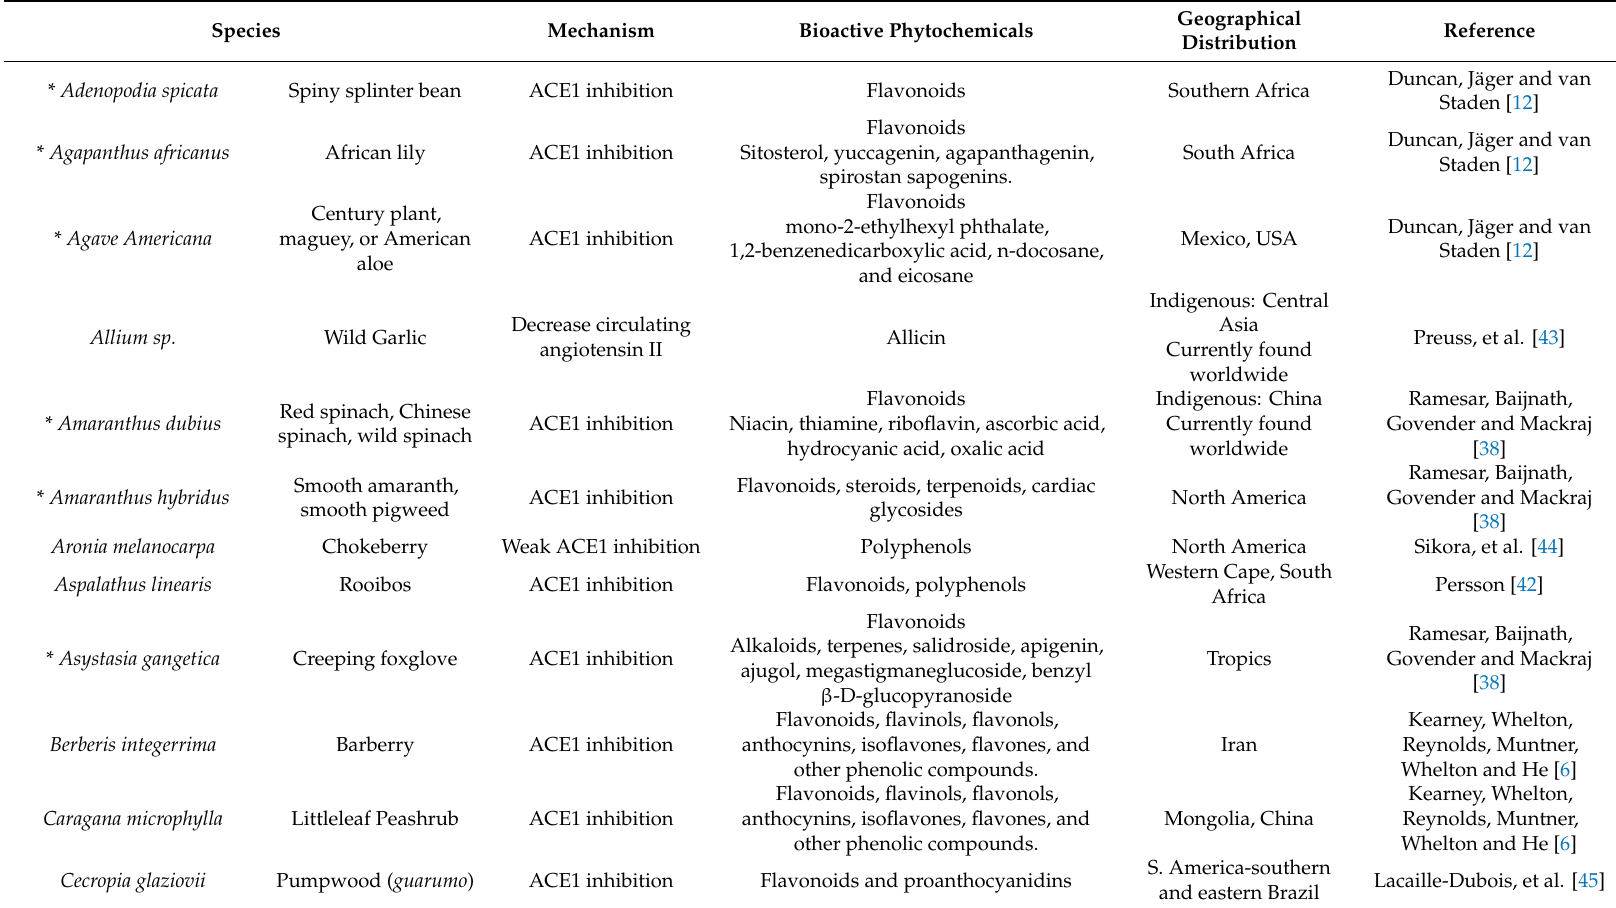
Table 1. Ethno-medicinal plants used in the treatment of hypertension by influencing the ACE1 renin–angiotensin (RAS) pathway.